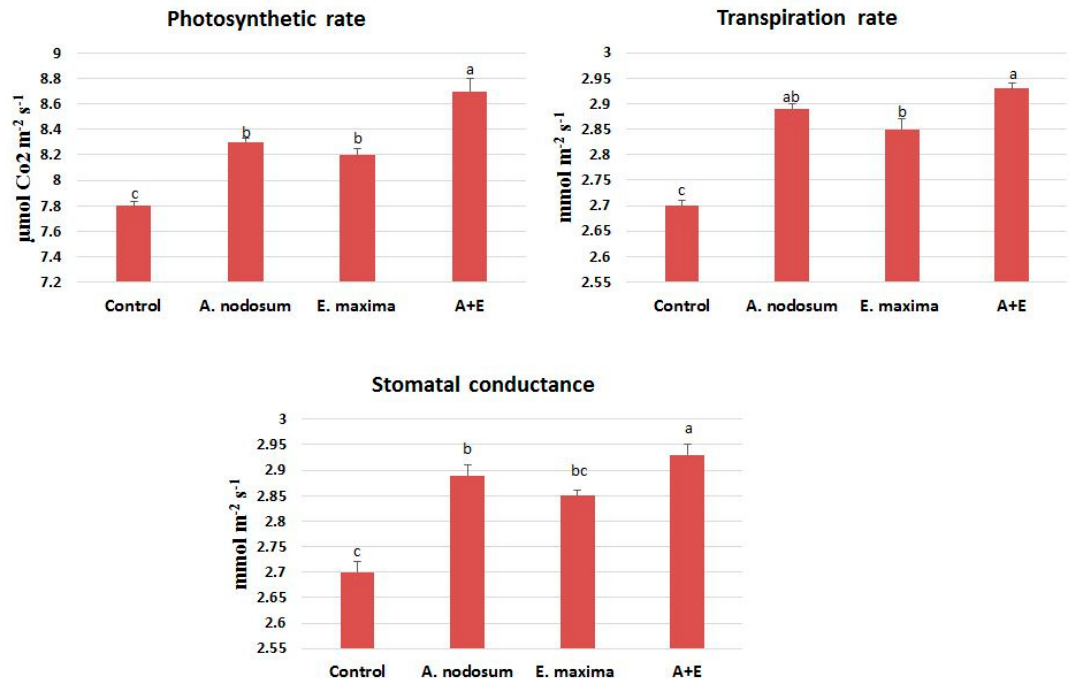
Figure 2. Gas exchange parameters measurements in plants subjected to seaweed treatments. Different letters on columns indicate significant differences among treatments at p ≥ 0.05. A + E: A. nodosum + E. maxima.